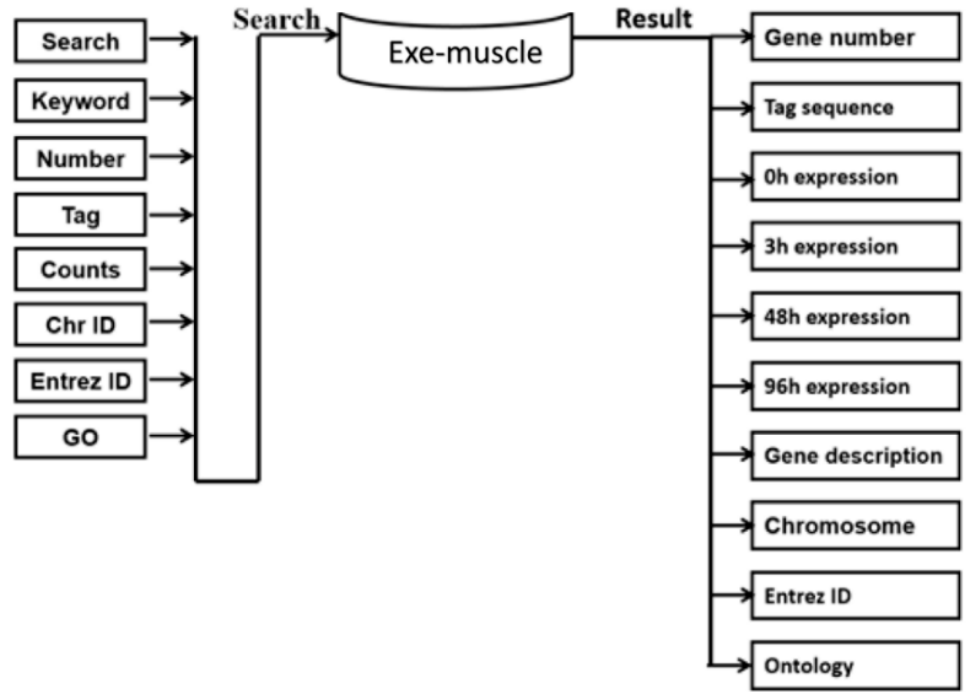
Figure 1. Construction of the Exe-muscle database. The diagram shows the framework of the Exe-muscle database visually. We searched by entering the keyword, number, tag, counts, Chr ID, Entrez ID, or GO (gene ontology) of the gene we wanted to discover. Relevant information was loaded in advance so that we could obtain the search results rapidly: gene number, tag sequence, 0 h expression, 3 h expression, 48 h expression, 96 h expression, gene description, chromosome, Entrez ID, and ontology.